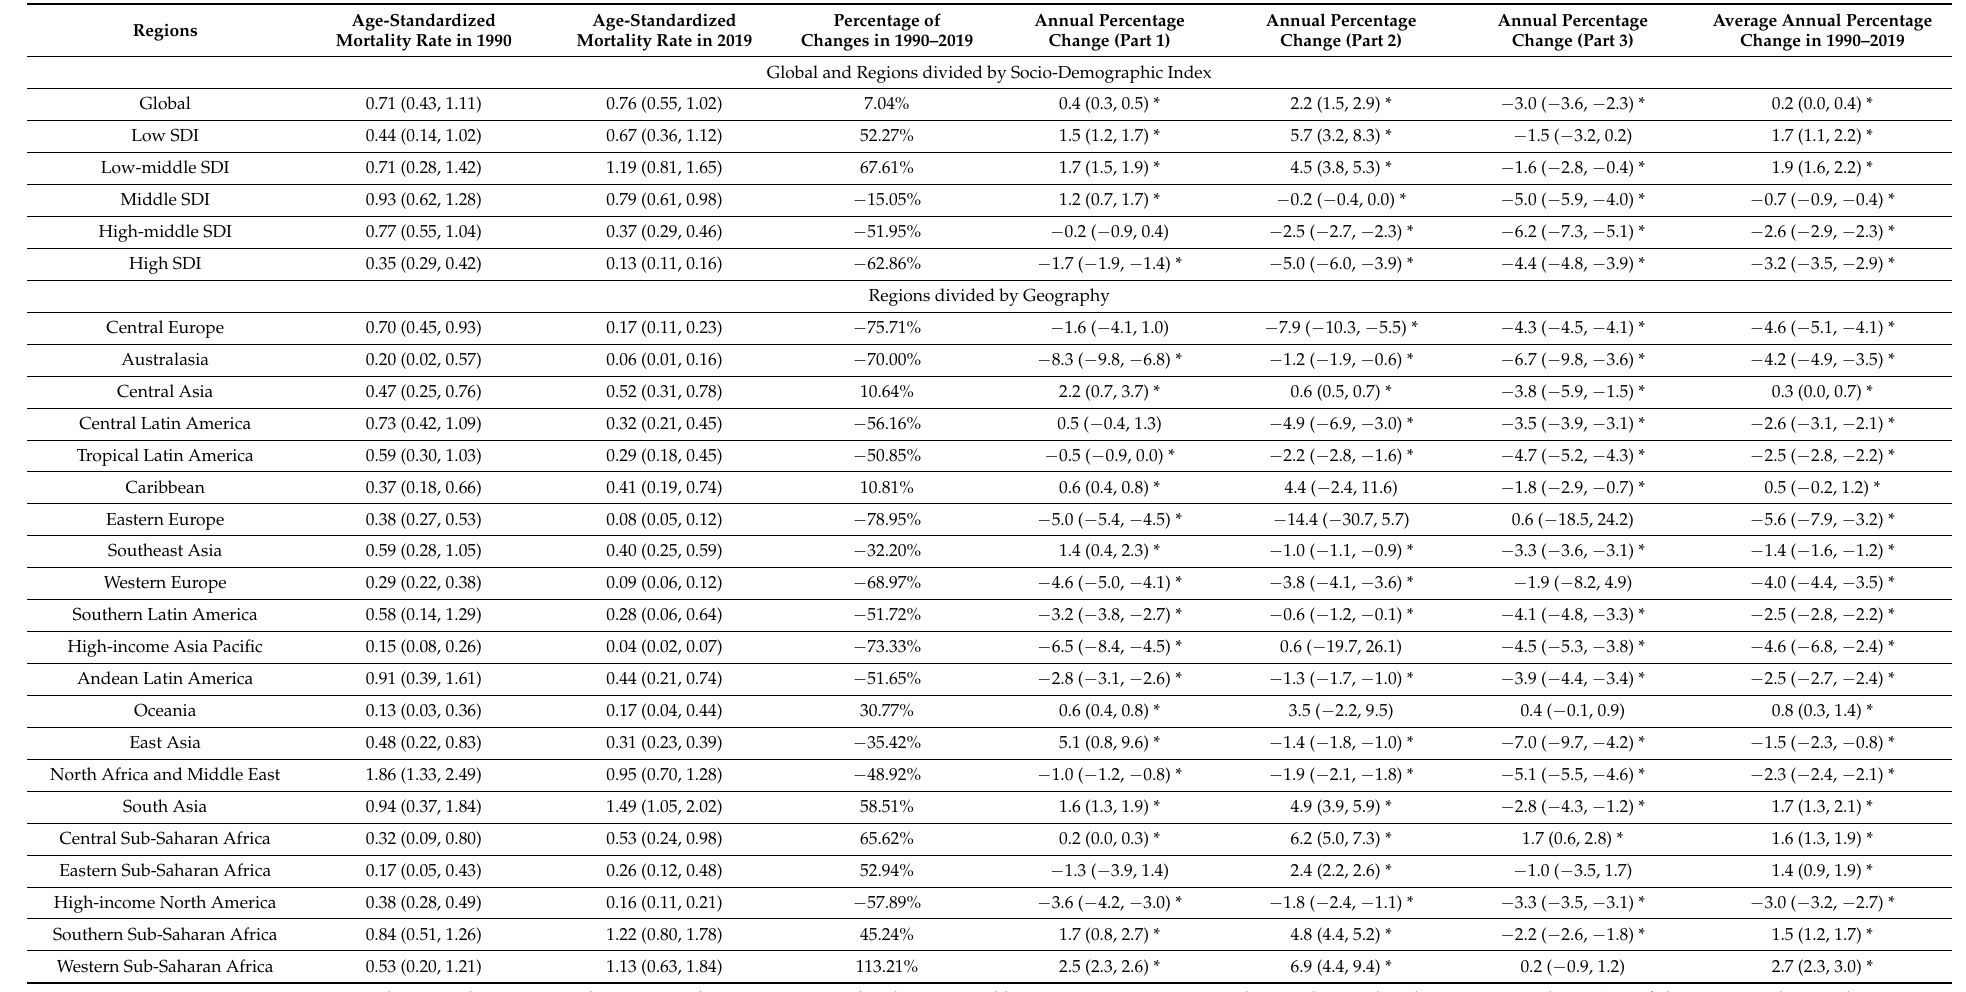
Table 1. Age-standardized mortality rate in PM 2.5 -related preterm birth: rate, percentage of changes, annual percentage changes, and average annual percentage changes in the global and different regions in